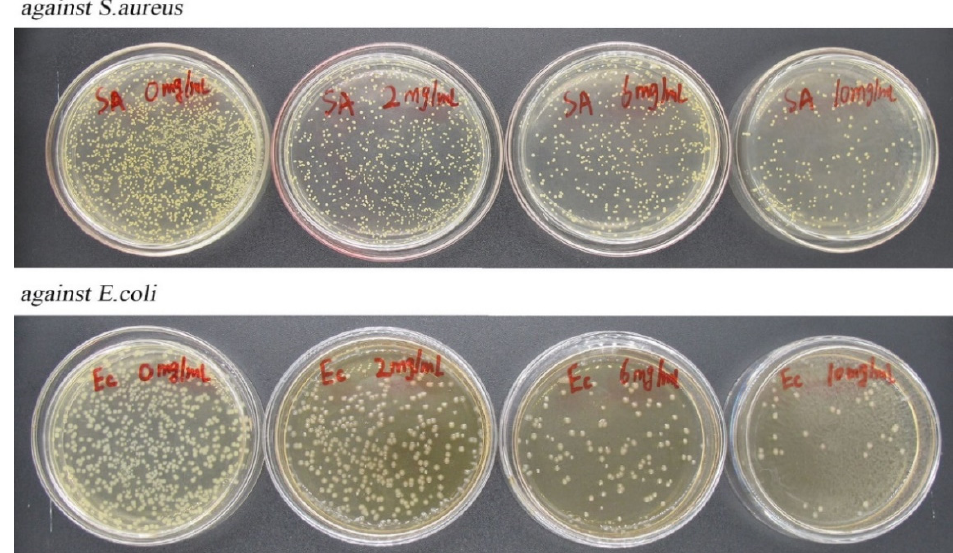
Figure 9. Antibacterial effect of zein/SC/CA composite NPs with different mass concentrations (0, 2, 6, and 10 mg/mL) against S. aureus and E. coli.